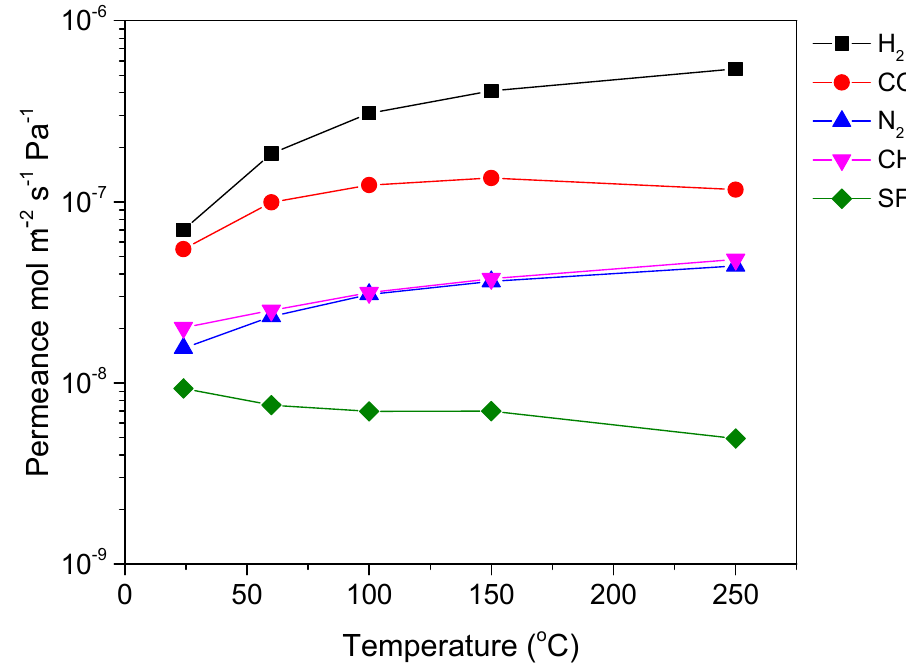
Figure 2. Single gas permeance of various gases as a function of temperature for commercial Hybrid silica (HybSi ® ) membrane M-A. Table 1. Permselectivity values of HybSi ® membrane M-A for various gas pairs, compared to the theoretical Knudsen values.